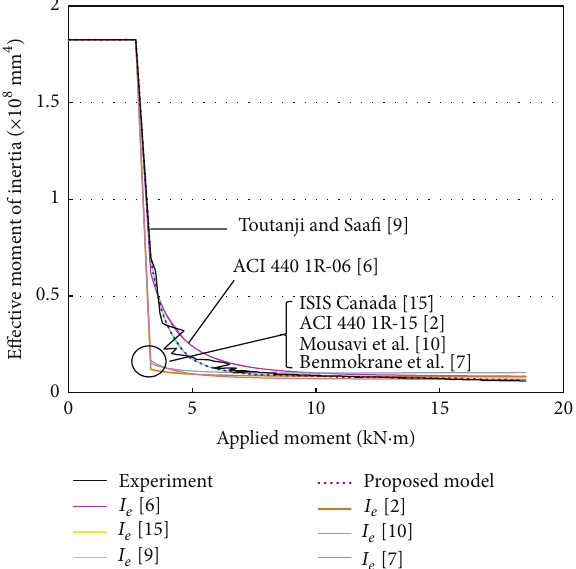
Figure 5: Effective moment of inertia of